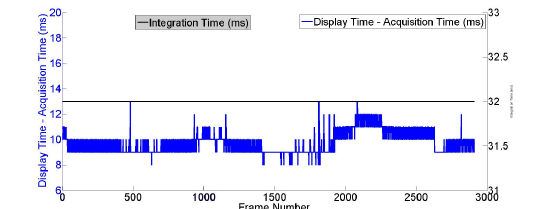
Figure 14: Evaluation of the difference of time between image acquisition and segment display with the integration time = 32ms